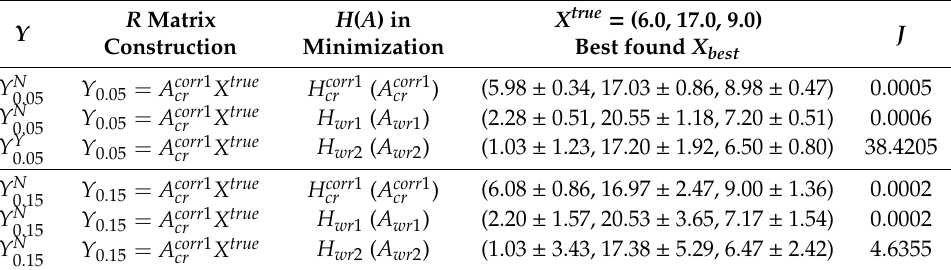
Table 1. Results for Case A, where Y N or Y d represent data from N measured radiances. The second d column means the R matrix is based on what for construction and the third column represents what